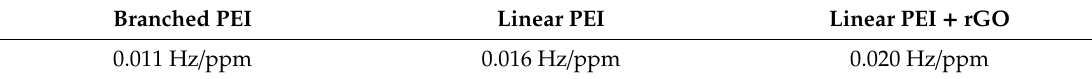
Table 2. Linearized coe ffi cient of the frequency shift by ppm of CO